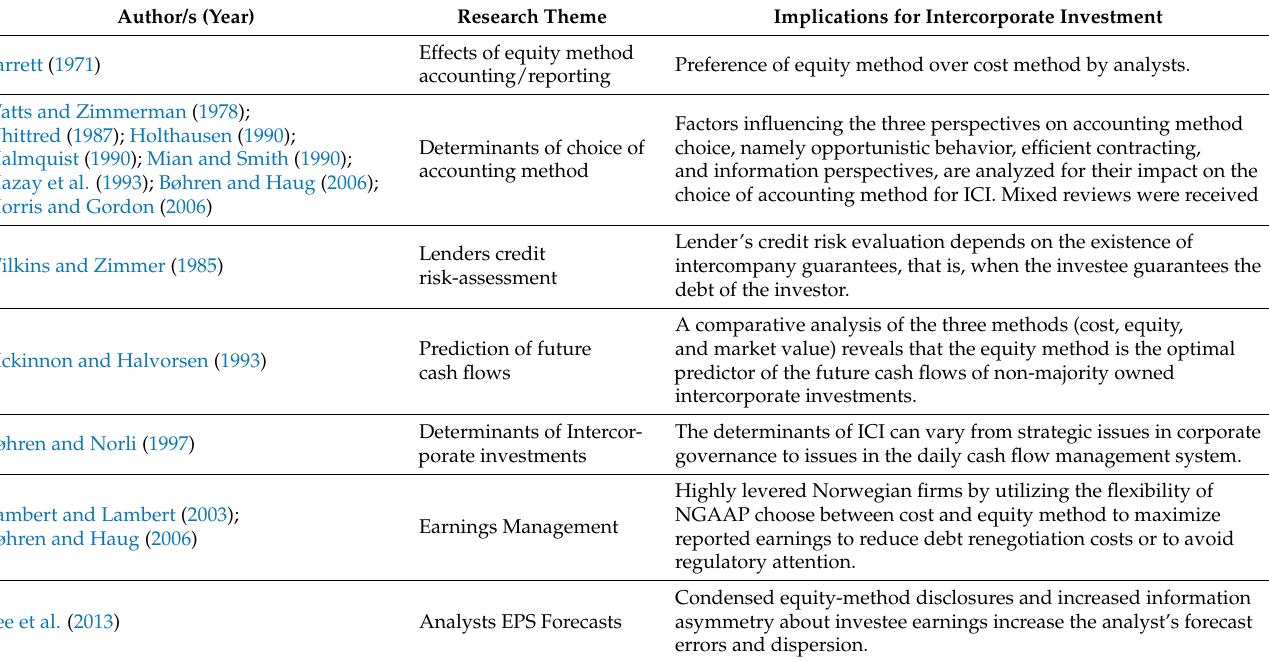
Table 1. Research Themes of existing literature and their implications on